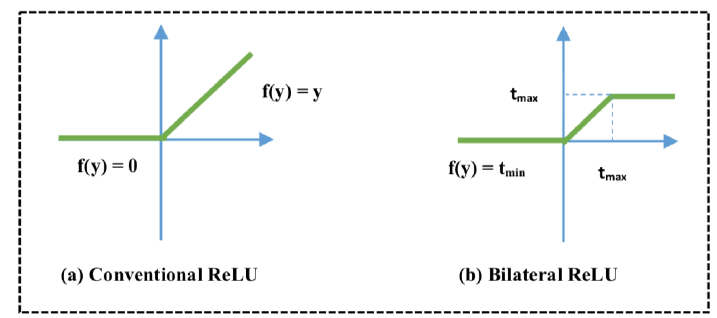
Figure 9. ReLU and BReLU Representations.